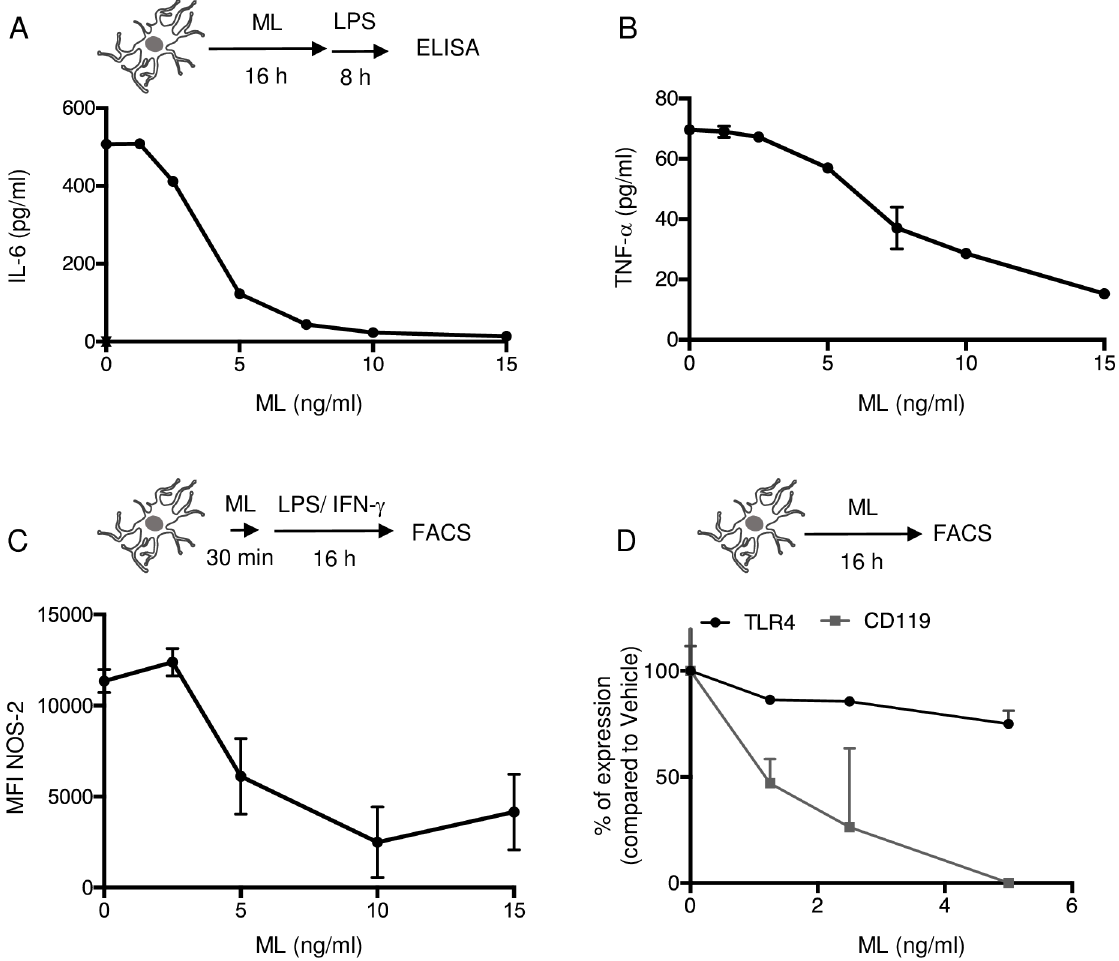
Fig 3. Mycolactone suppresses the production of pro-inflammatorymediators by activated microglia. IL-6 (A) and TNF- α (B) productionby primarymouse cortical microglia exposedto mycolactone (ML) or vehiclefor 16 h, prior to a 8 h activationwith 100 ng/ml LPS. (C) Flow cytometry analysisof intracellularNOS-2 in primary corticalmicrogliapre-treatedwith ML for 30 min, prior to 16 h activationwith 100 ng/ml LPS + 20 ng/ml IFN- γ , in presenceof ML. (D) Flow cytometry analysisof surface expression of TLR4 (black) and IFN- γ receptor (CD119,gray) in microgliaexposedto ML for 16 h. Data are meansIL-6 or TNF- α levels ± SEM (A-B), mean fluorescence intensity ± SEM (C) and meanpercentage of suppression comparedto vehicle(D) of duplicates, and are representative of two independent